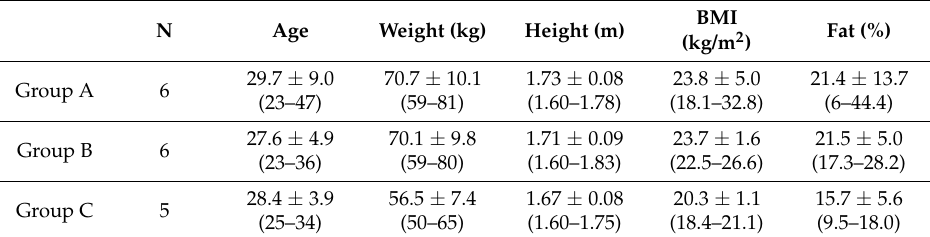
Table 2. VOCs exposure measurement participants’ physical parameters.